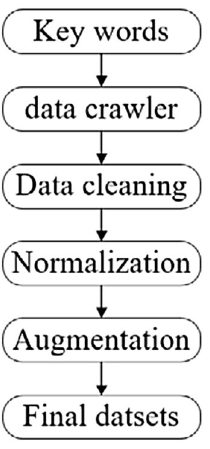
Figure 1. The acquisition process of